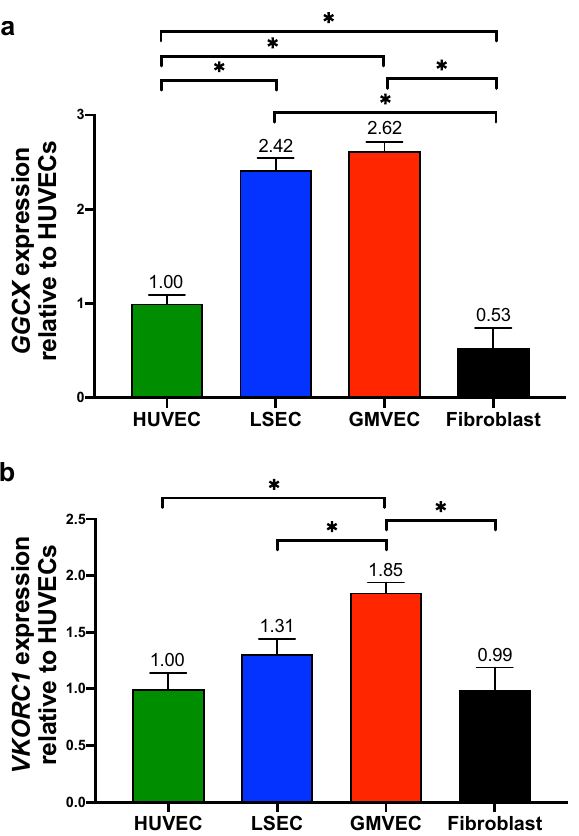
Figure 3. Gene expression of GGCX and VKORC1 in ECs and fibroblasts. HUVEC, LSEC, GMVEC, and fibroblast expression levels of ( a ) GGCX (γ-glutamyl carboxylase) and ( b ) VKORC1 (vitamin K epoxide reductase complex subunit 1) were analyzed by real-time PCR and quantified relative to gene expression levels in HUVECs. Data shown are means + SD from triplicate PCR measurements (n = 3 for each cell type). * p < 0.05.